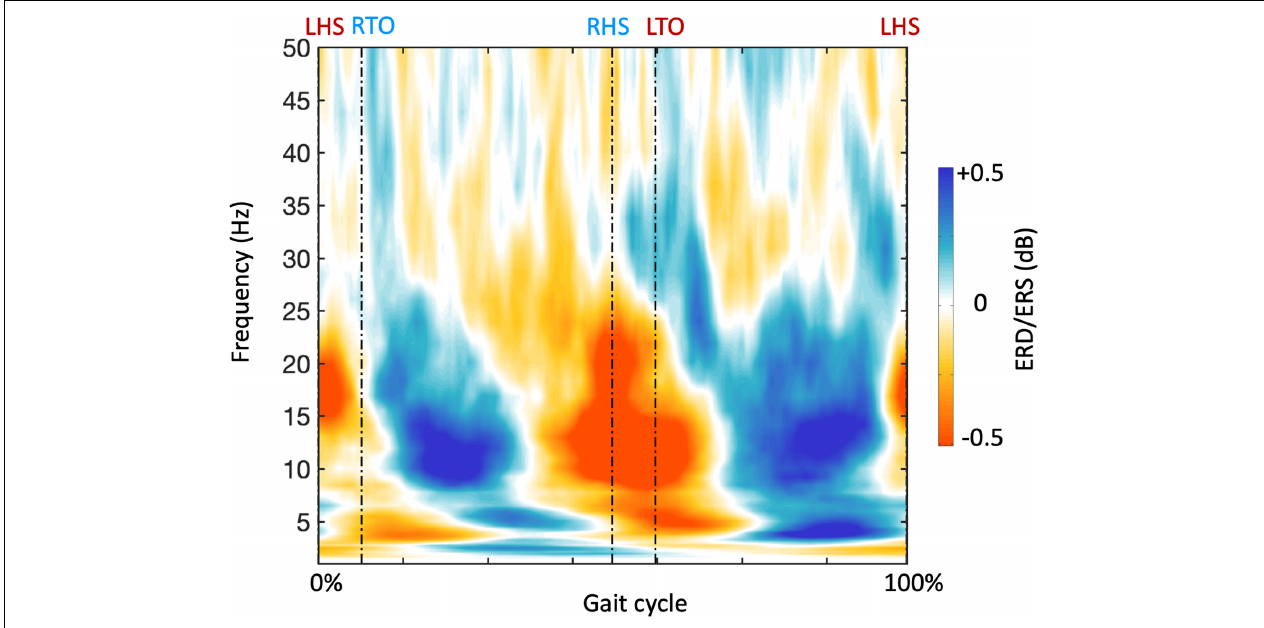
FIGURE 6 | Gait-related time-frequency analysis for a representative region of interest. The plot shows the average frequency-dependent modulations of neural signals in the gait cycle across participants, calculated from the neural signal of the right primary motor cortex (M1). The timing of gait events is indicated using dashed vertical lines. LHS, left heel strike; RHS, right heel strike; LTO, left toe off; RTO, right toe off.